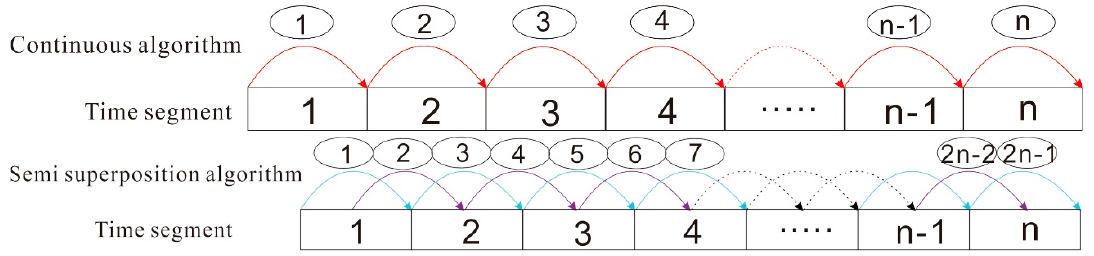
Figure 3. The two proposed algorithms for the treatment of the TRT.